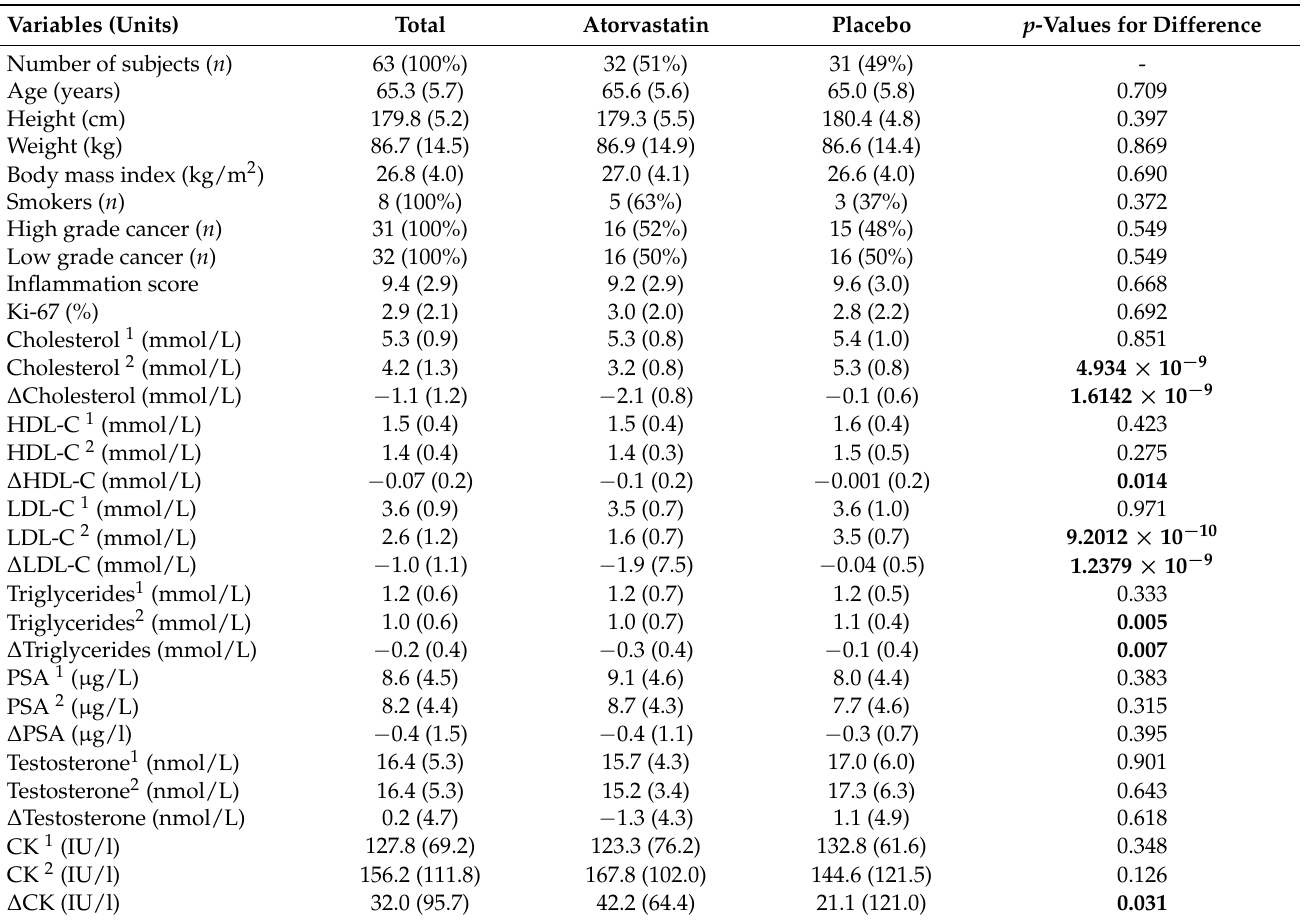
Table 1. Characteristics of the study subjects. Continuous variables are presented as mean values with standard deviations in the parentheses. Mann–Whitney U-test was used for continuous variables and χ 2 test for categorical variables to calculate differences between atorvastatin and placebo arms of the study. Statistically significant differences ( p -values < 0.05) between study arms are